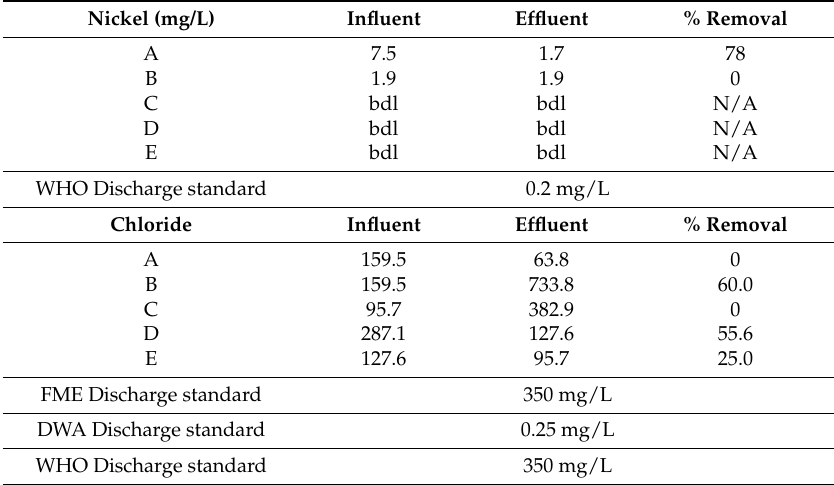
Table 2. WWTP removal efficiencies of Companies A–E for Nickel and Chloride. Nickel